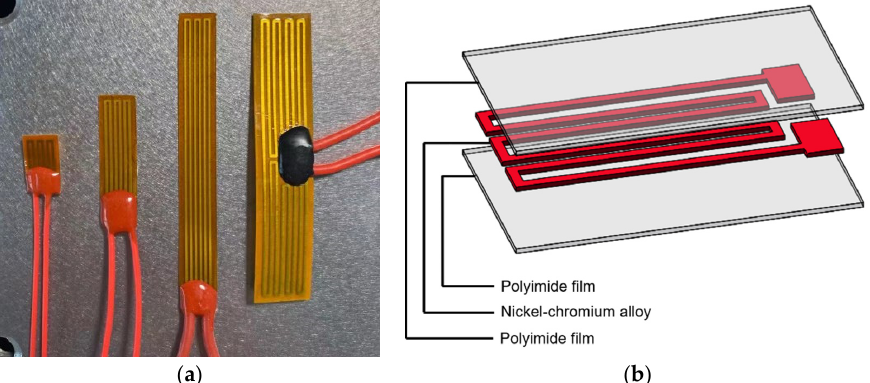
Figure 9. The polyimide films. ( a ) The polyimide electrothermal film; ( b ) Structure of polyimide electrothermal film. Table 4. Comparison of output displacement between analytical and experimental results